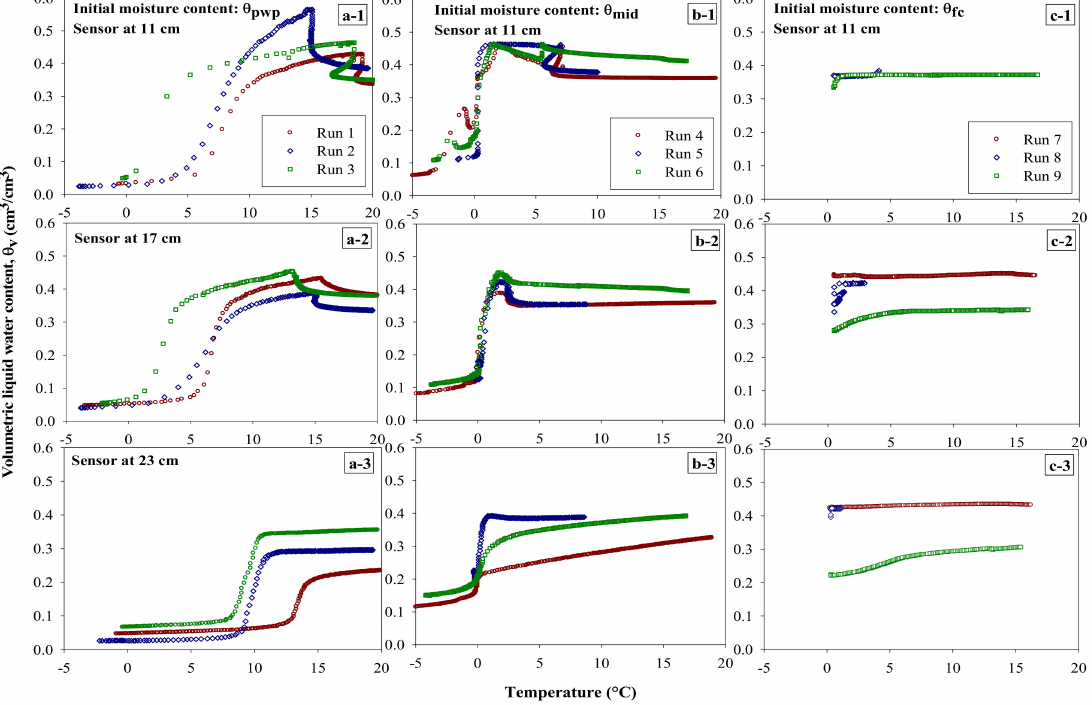
Figure 11. Volumetric liquid water content ( θ v ) vs. temperature, plotted for ( a ) Runs 1, 2, and 3 with initial water content of permanent wilting point ( θ pwp ); ( b ) Runs 4, 5, and 6 with initial water content between θ pwp and field capacity ( θ fc ); and ( c ) Runs 7, 8, and 9 with initial water content θ fc at depths of 11, 17, and 23